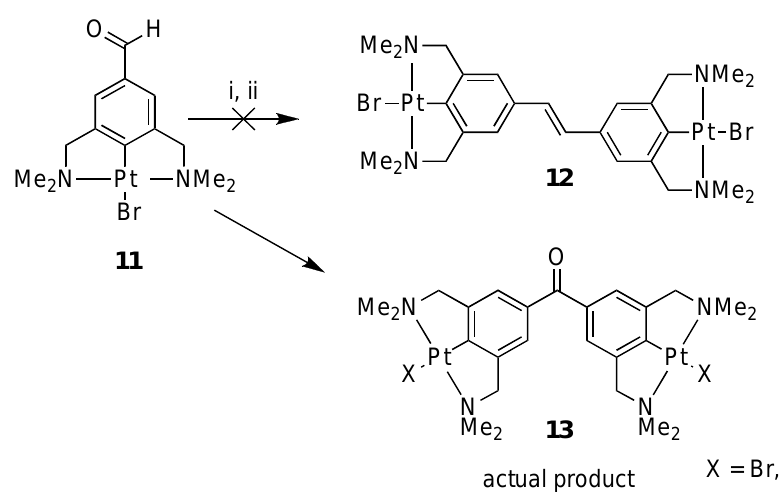
Scheme 2. Reagents and conditions : (i) TiCl 4 (THF) 2 , Zn(0), THF, reflux, 16 h; (ii) H 2 O, K 2 CO 3 .